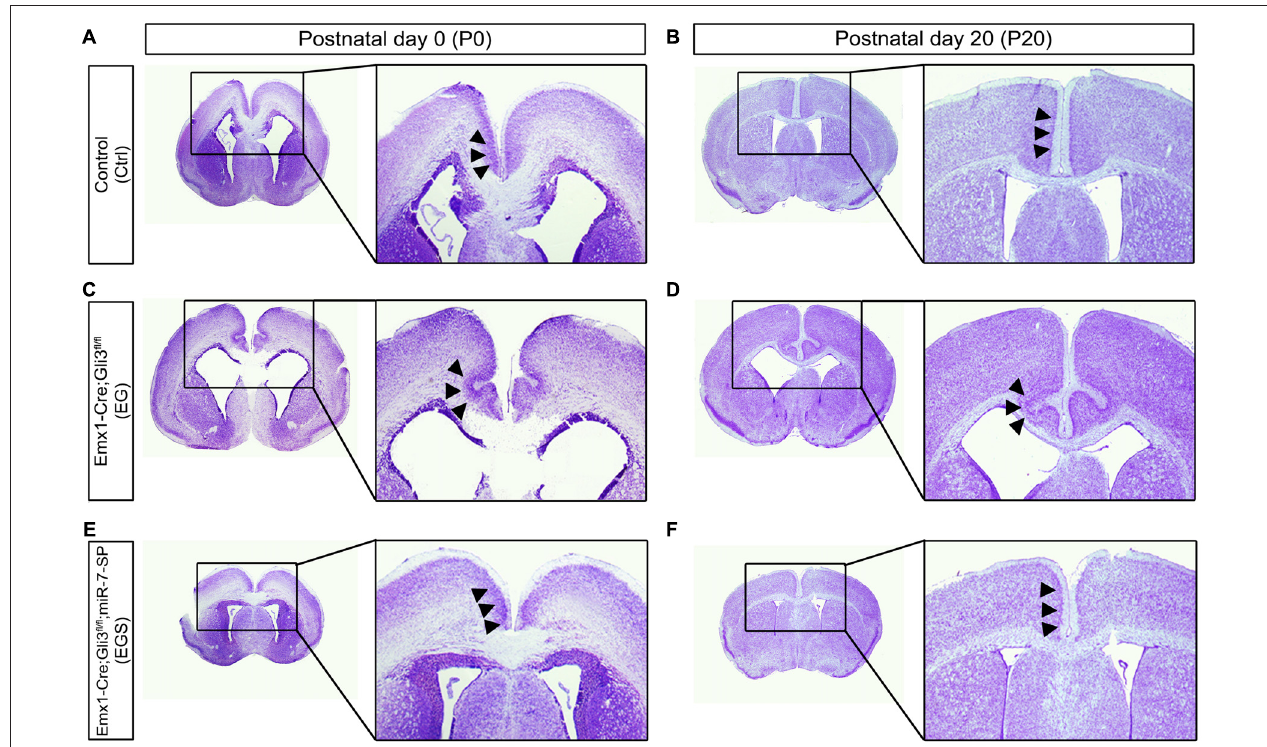
FIGURE 2 | Gli3-deficiency induces abnormal morphogenesis in the cortical midline. (A,B) Normal-developing brains displayed smooth cortical surface at the midline of cortices at P0 and P20. (C,D) Cortices losing Gli3 showed in-folding phenotype at the midline of cortices at P0, and the defect is maintained at P20. (E,F) Conditionally blocking the function of miR-7 from the cerebral cortex corrected the mis-folding defect in the midline in the Gli3 -deficient brain.